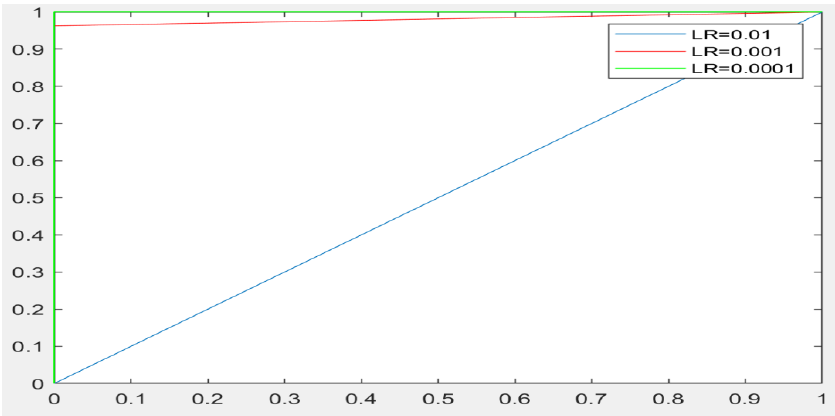
Figure 8. The ROC curves showing the performance of GoogLeNet on testing data sets with learning rates of 0.01, 0.001, and 0.0001.